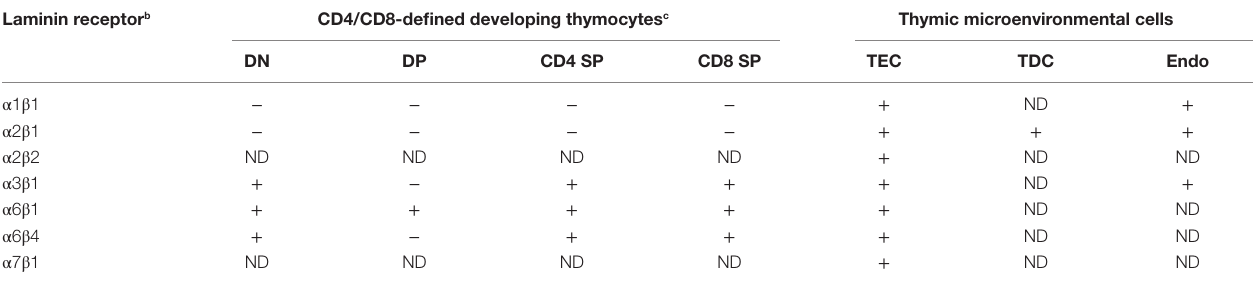
TABLe 3 | expression of integrin-type laminin receptors by developing thymocytes and thymic microenvironmental cells a . Laminin receptor b CD4/CD8-defined developing thymocytes